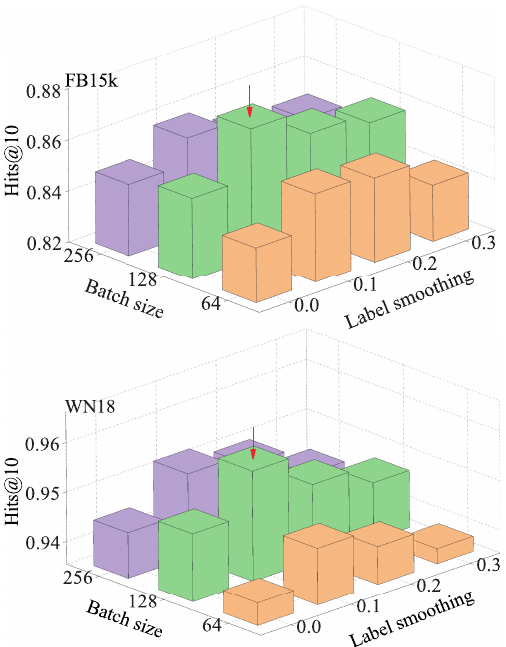
Figure 4. The Hits@10 performance with various batch sizes and label smoothing on the WN18 and datasets.